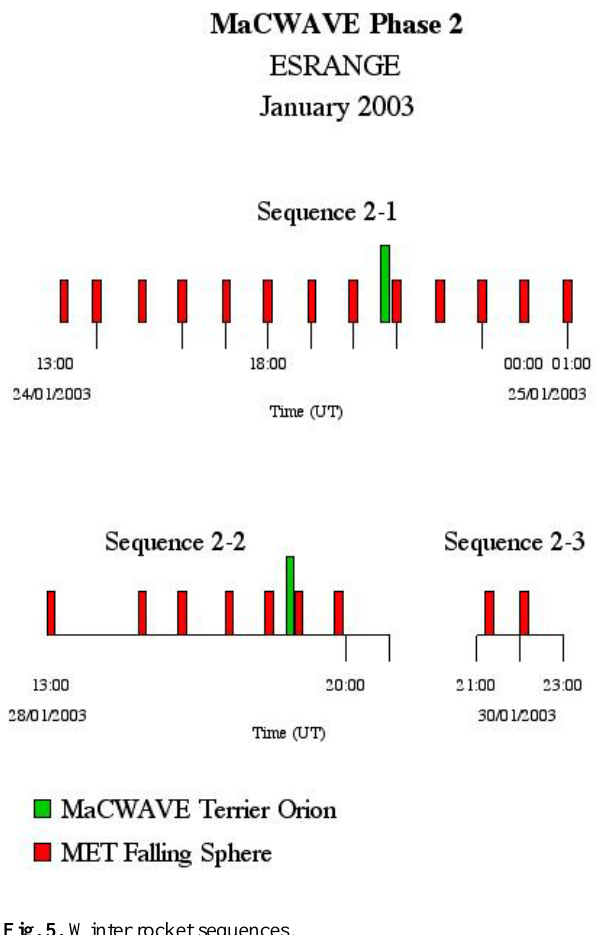
Fig. 5. Winter rocket sequences. Table 2. MaCWAVE winter launch and rocket information